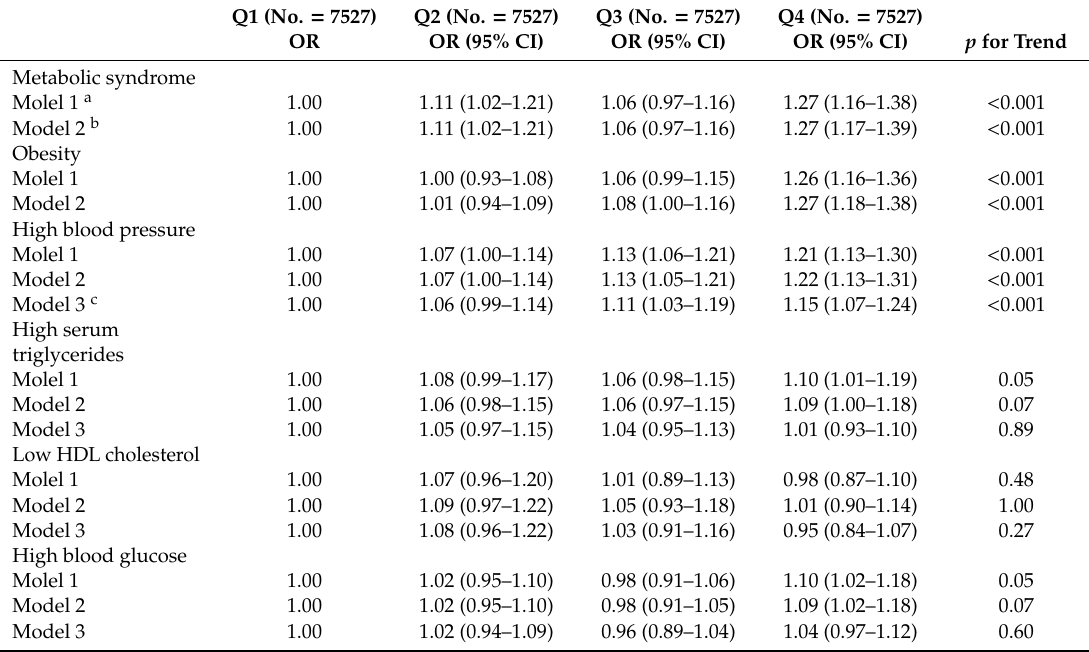
Table 4. Associations of Factor 2 (fats and fat-soluble vitamins pattern) scores with metabolic syndrome and its components.